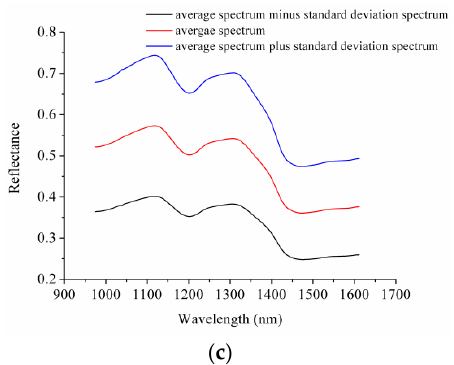
Figure 1. ( a ) Full spectra and ( b ) average spectra of the samples under 4 different treatments; ( c ) Average spectrum, average spectrum minus standard deviation spectrum, and average spectrum plus standard deviation spectrum of a randomly selected sample.